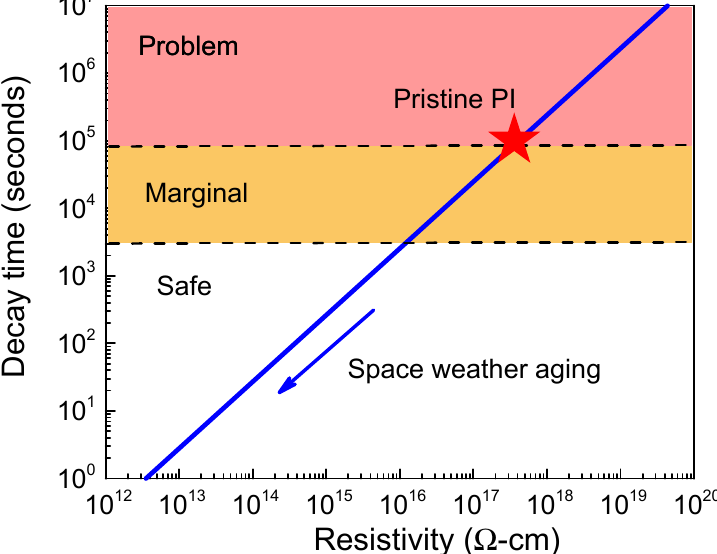
Figure 2. Plot of charge decay time versus resistivity value for PI. The red star indicates the resistivity of pristine PI. Note, that after electron irradiation the resistivity can decrease by several orders of magnitude. Adapted with modifications from [56].